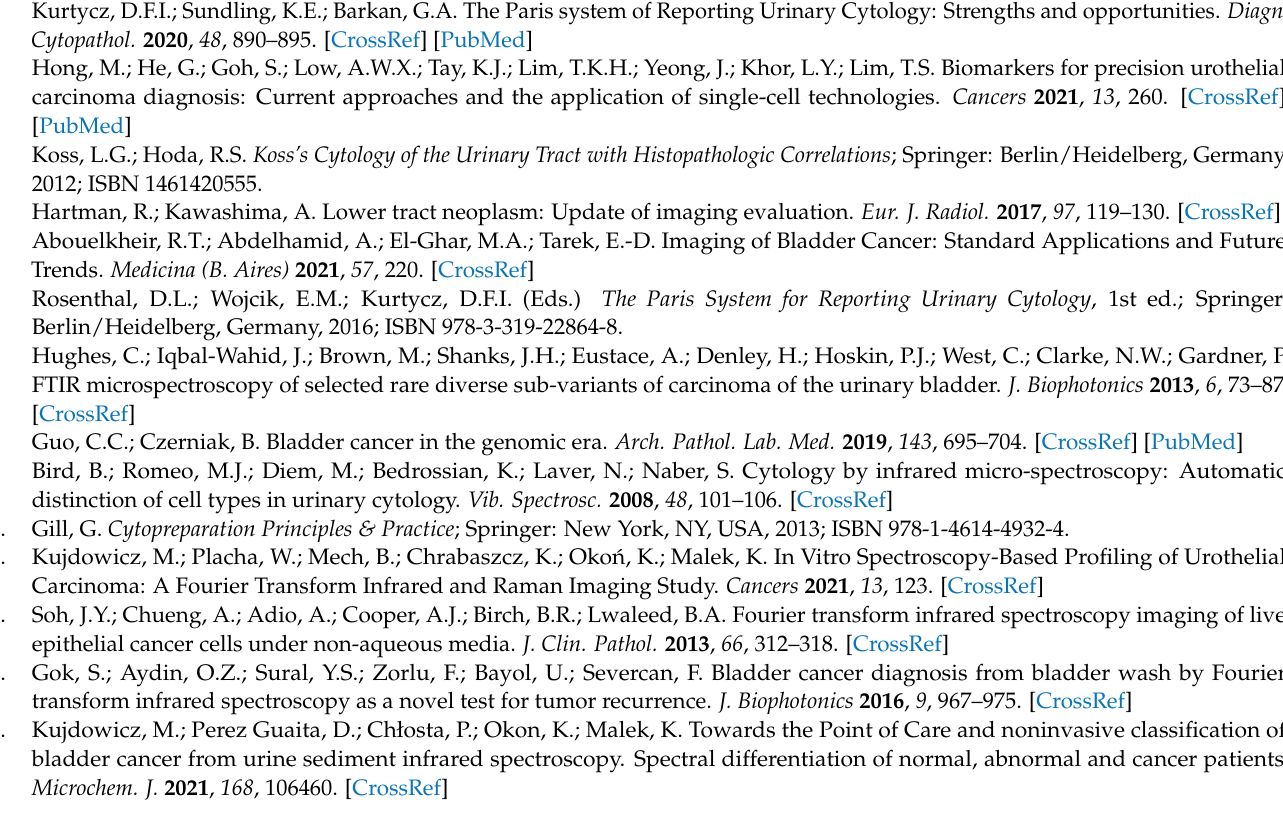
Figure S4: Example of cluster analysis from one of N, LG and HG BC patients. Spectra from the most different branches of Cluster Analysis were chosen to build the model, were marked with arrows and they represent 9 out of 18 spectra from the patient, Table S1: Normal, LG and HG BC cell features according to the Paris system, Table S2: Positions of IR bands observed in FTIR spectra of urine sediment with their assignment to vibrational modes and biomolecules, Table S3: PLS-DA parameters for discrimination of LG and HG BC cytology from normal urothelial